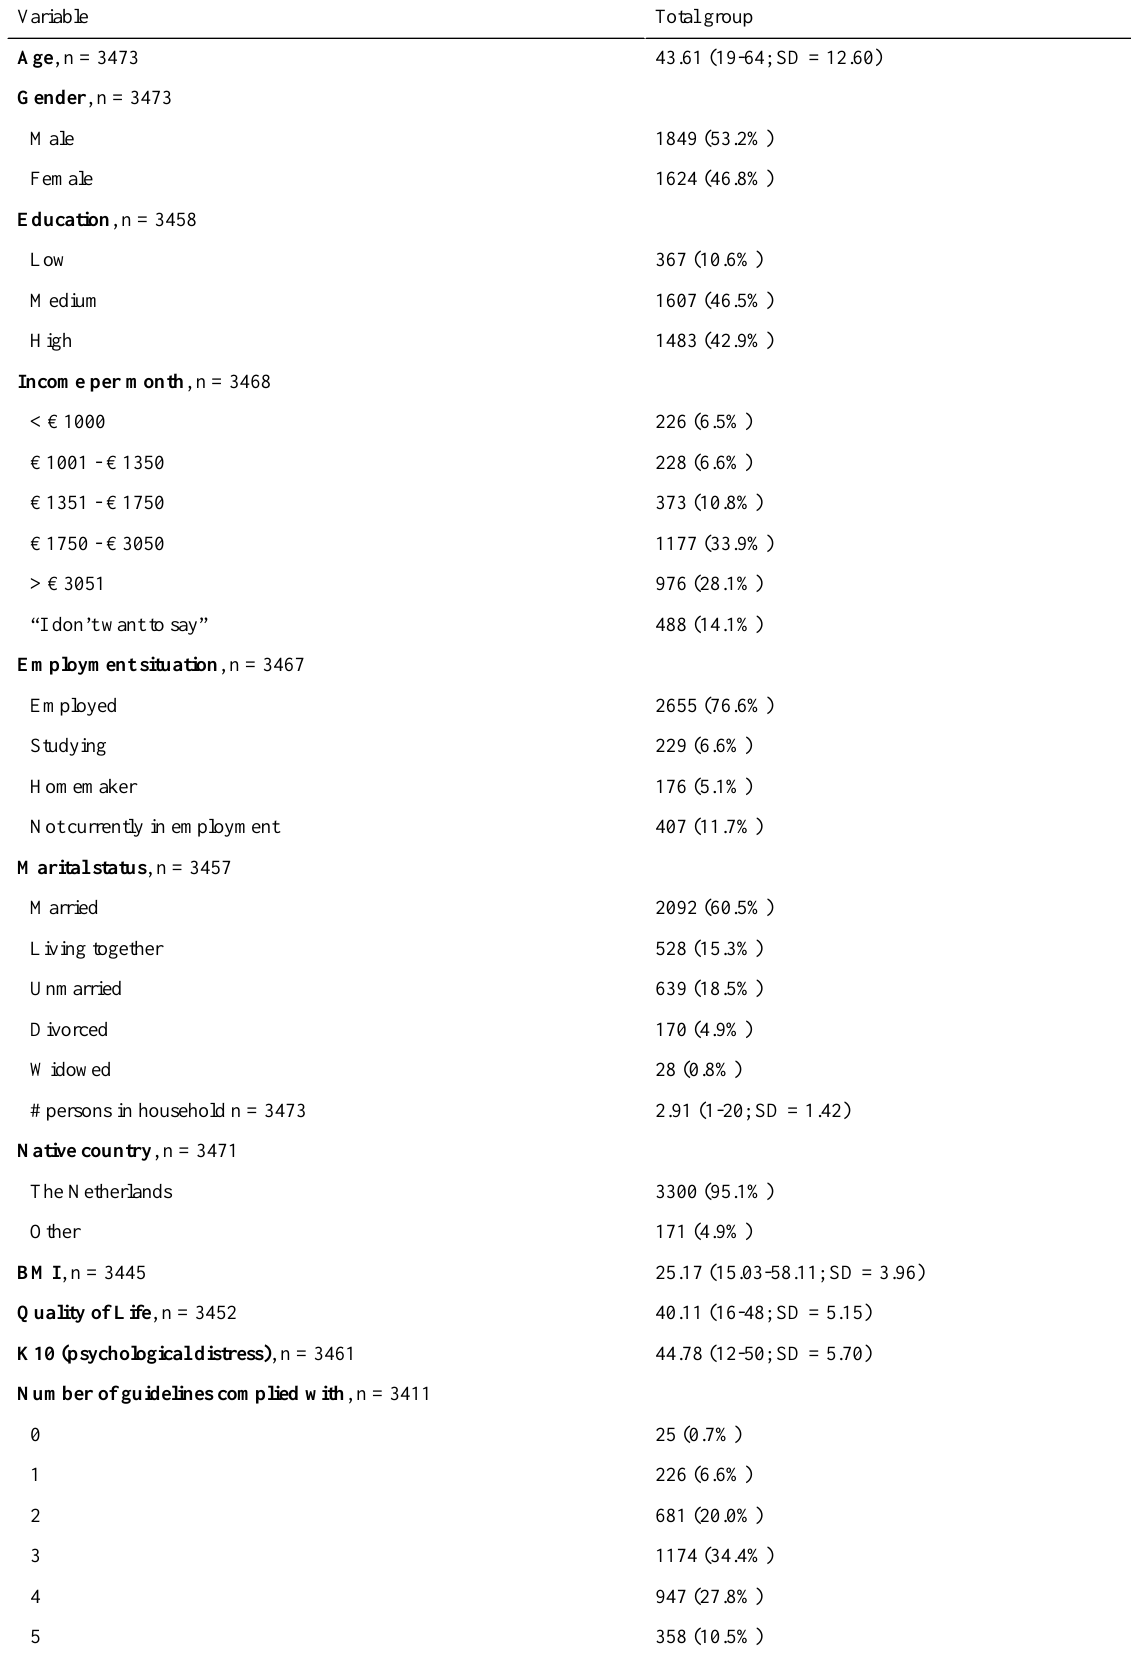
Table 1. Demographics, health status and lifestyle of the study sample (N =